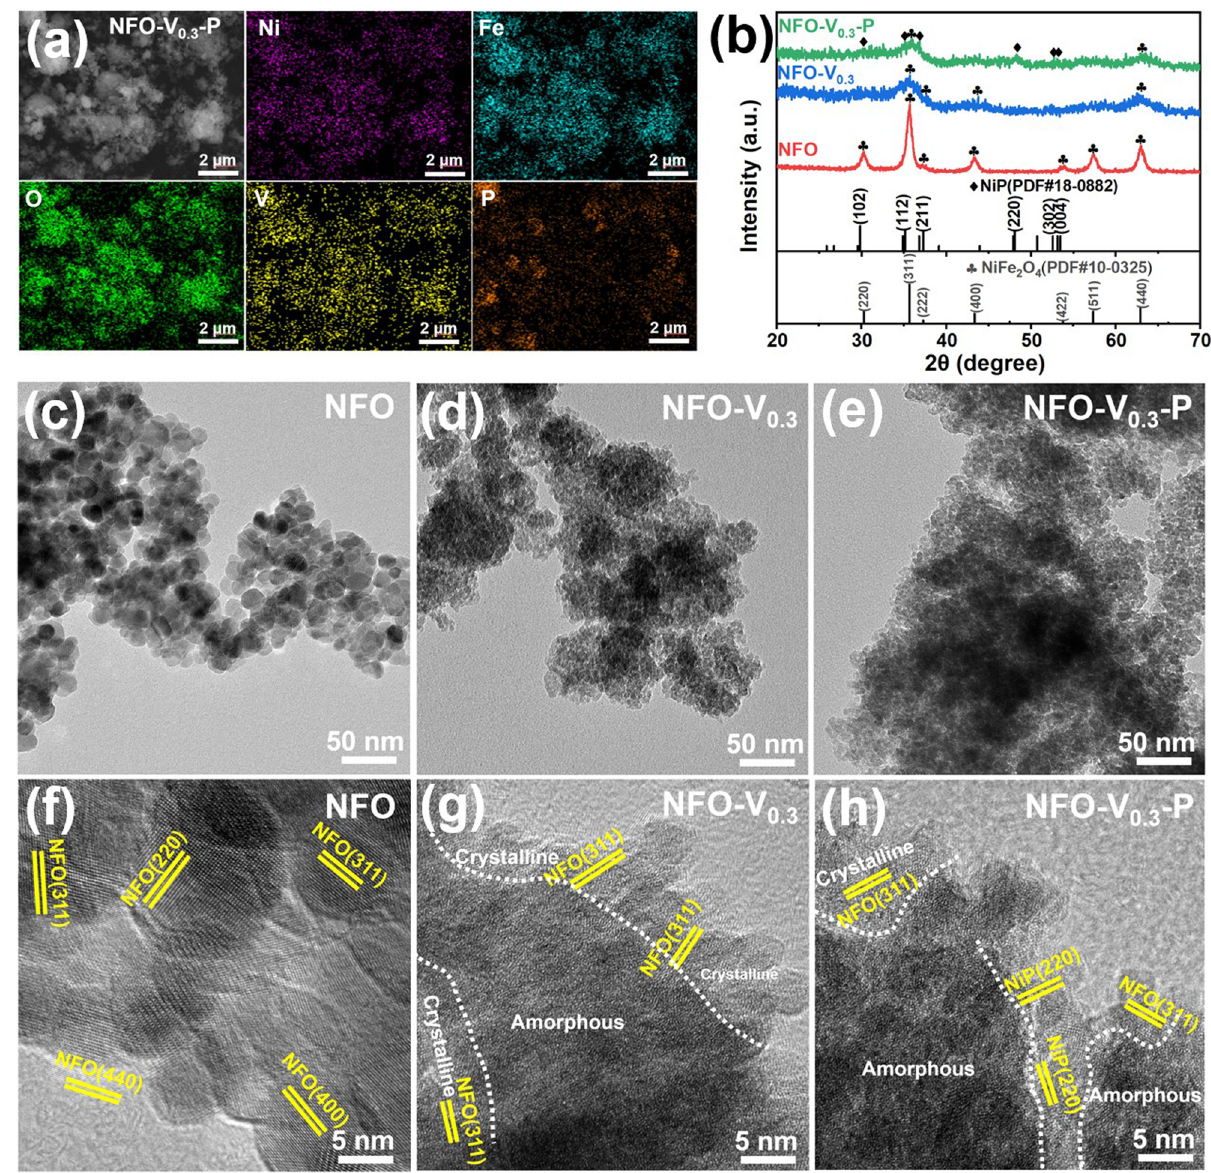
Figure 2: ( a ) SEM image and the corresponding elemental mapping of NFO - V 0.3 - P. ( b ) XRD patterns of NFO, NFO - V 0.3 , NFO - V 0.3 - P. ( c – e ) TEM and ( f – h ) HRTEM image of NFO, NFO - V 0.3 , NFO - V 0.3 -